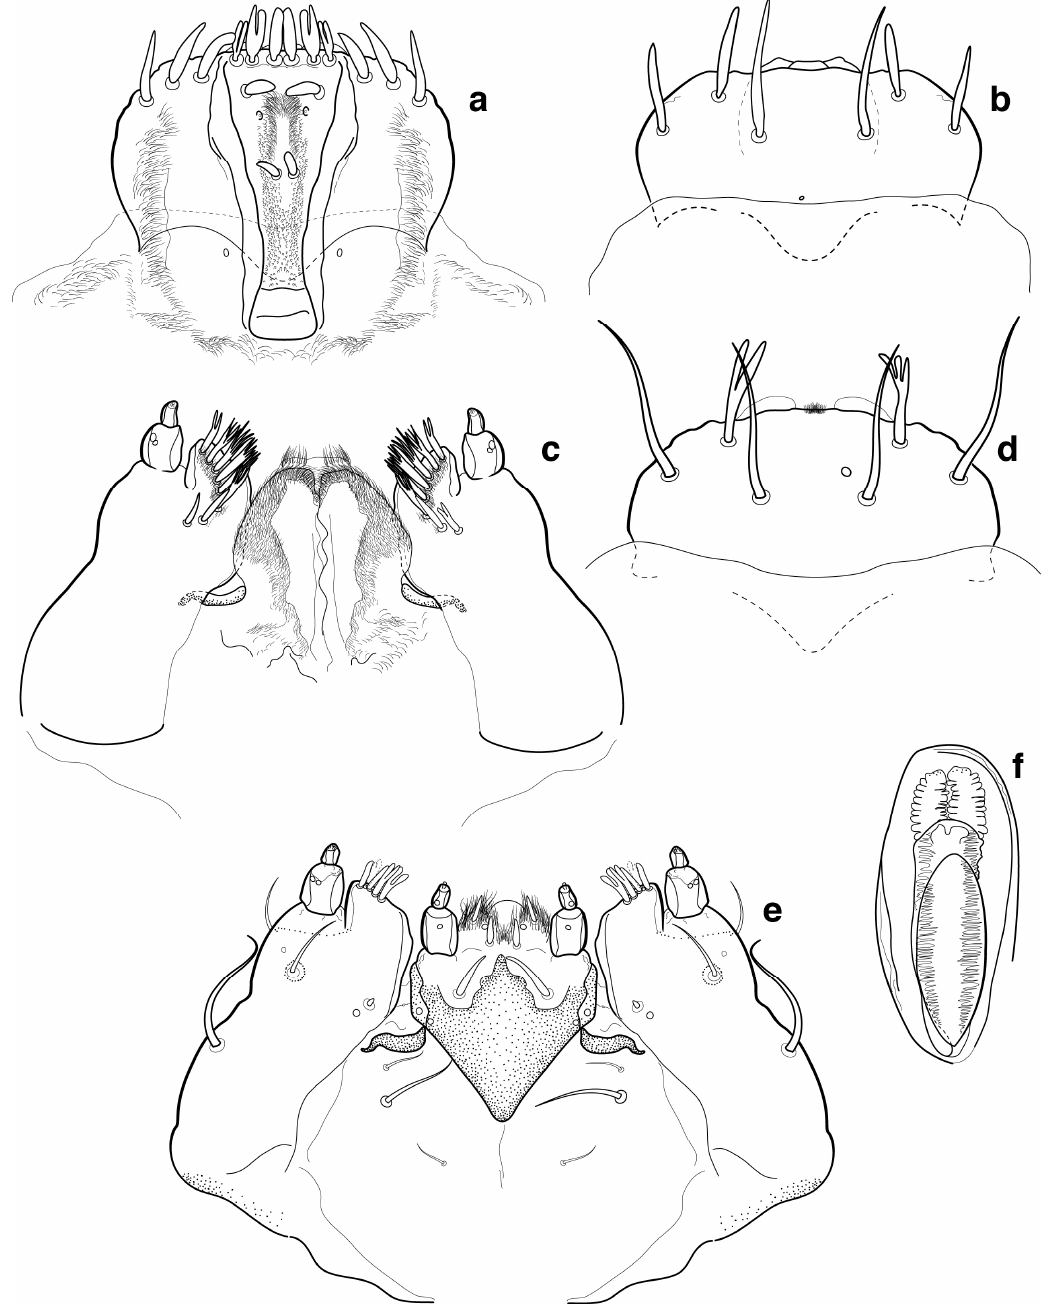
Figure 67. Metamasius ritchiei mouthparts: ( a ) epipharynx; ( b ) clypeus (incomplete) and labrum; ( c ) maxillae and hypopharynx, dorsal view; ( d ) Metamasius hemipterus clypeus (incomplete) and labrum; ( e ) labio-maxillary complex, ventral view; and ( f ) thoracic spiracle.